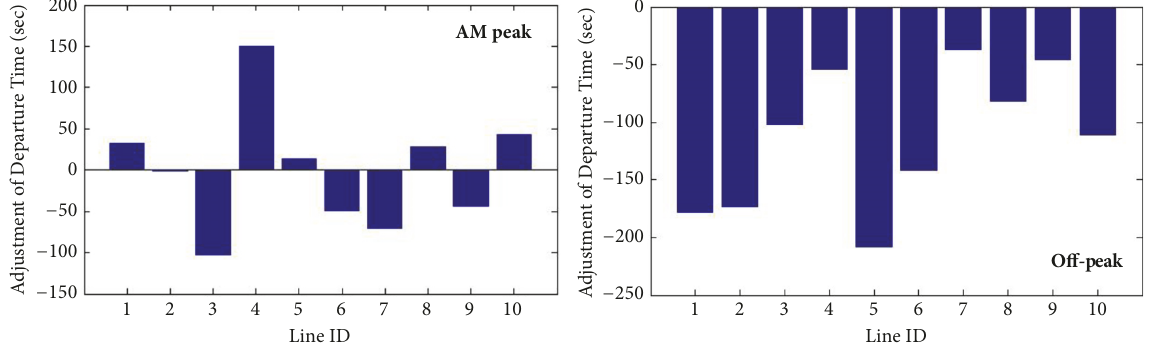
Figure 7: Optimized adjustment of departure times with SAPC (AM and off-peak).